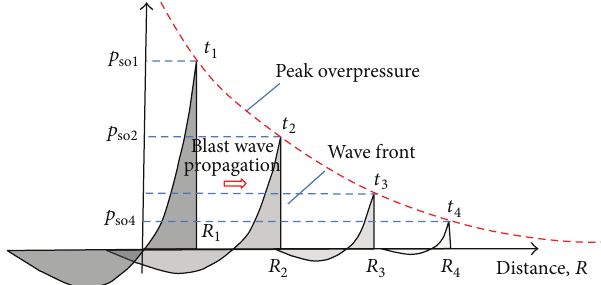
Figure 5: Attenuation of peak overpressure with distance from source: blast wave